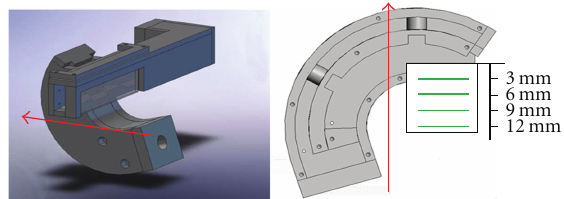
Figure 8: Positions of the four experimental planes within the UCC main flow channel for the curved circumferential section. Measurement planes at 3mm, 6mm, 9mm, and 12 mm (not drawn to scale) are shown on the right. The section is rotated, as indicated by the arrow, to show two views.